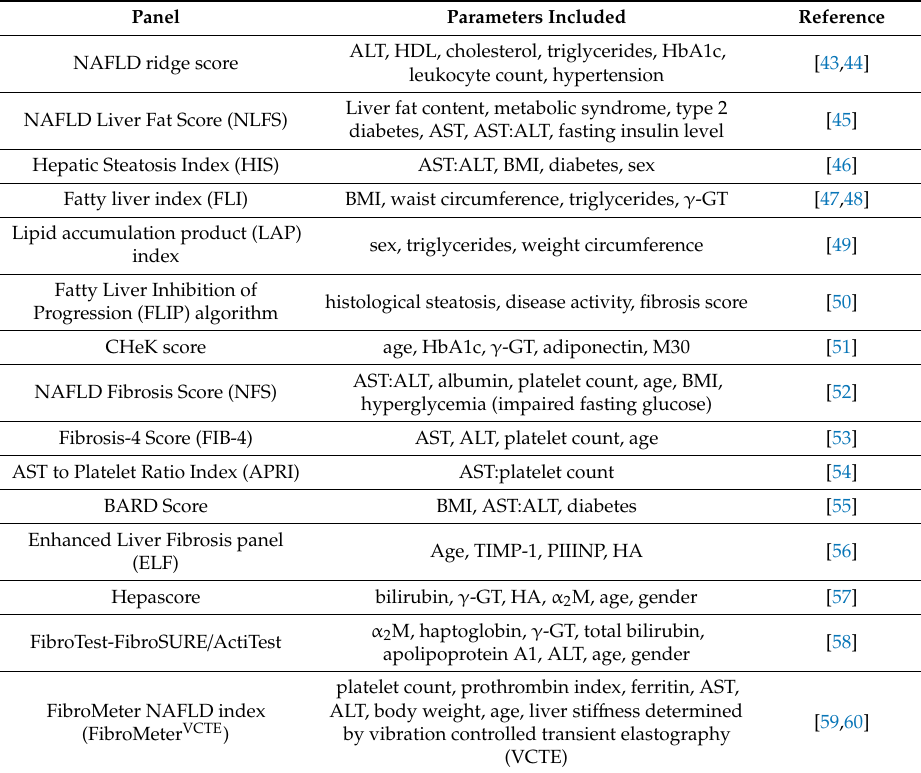
Table 1. Blood biomarker panels to identify inflammatory liver disease.